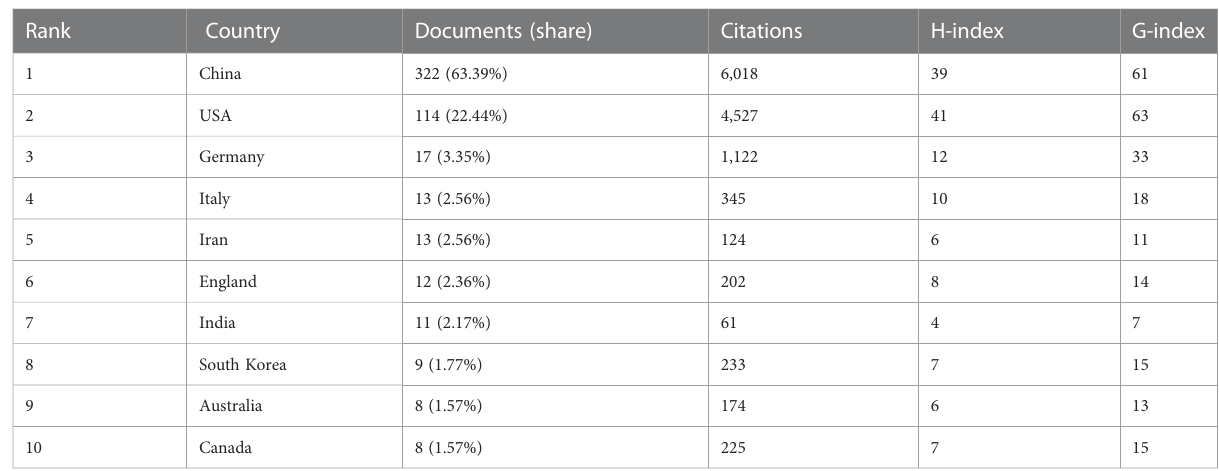
TABLE 1 The top 10 proli fi c